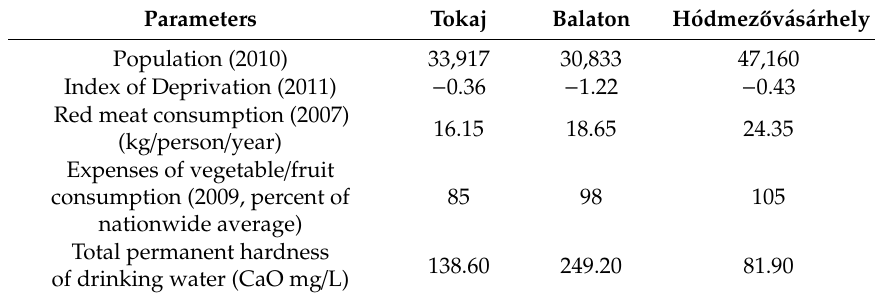
Table 1. Population, index of deprivation, consumption of red meat as well as vegetables / fruits and total hardness of drinking waters in the three regions between 2000 and